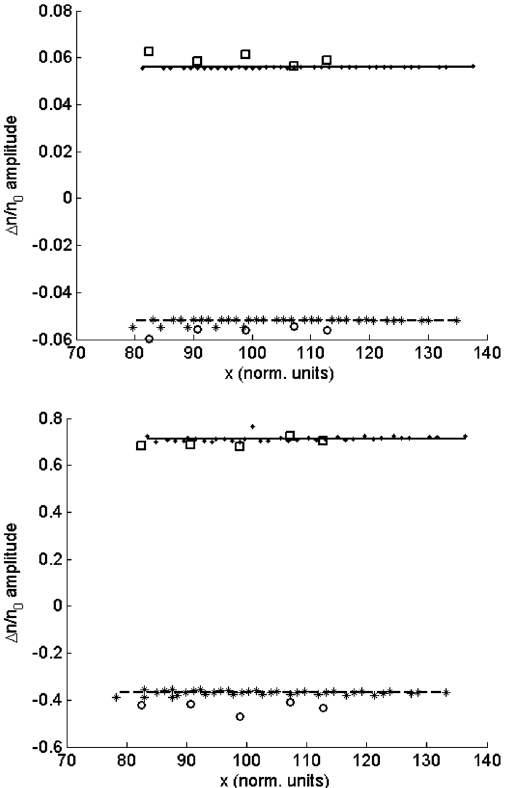
FIG. 5. Comparison between actual density modulation profile peaks (dots) and troughs (stars) with the measured density modulation profile (squares and circles). Solid and dash lines show the average values of the peaks and troughs of the actual density modulation profile, respectively. The top picture shows the comparison for small wakefield amplitude and the bottom picture for large wakefield amplitude.